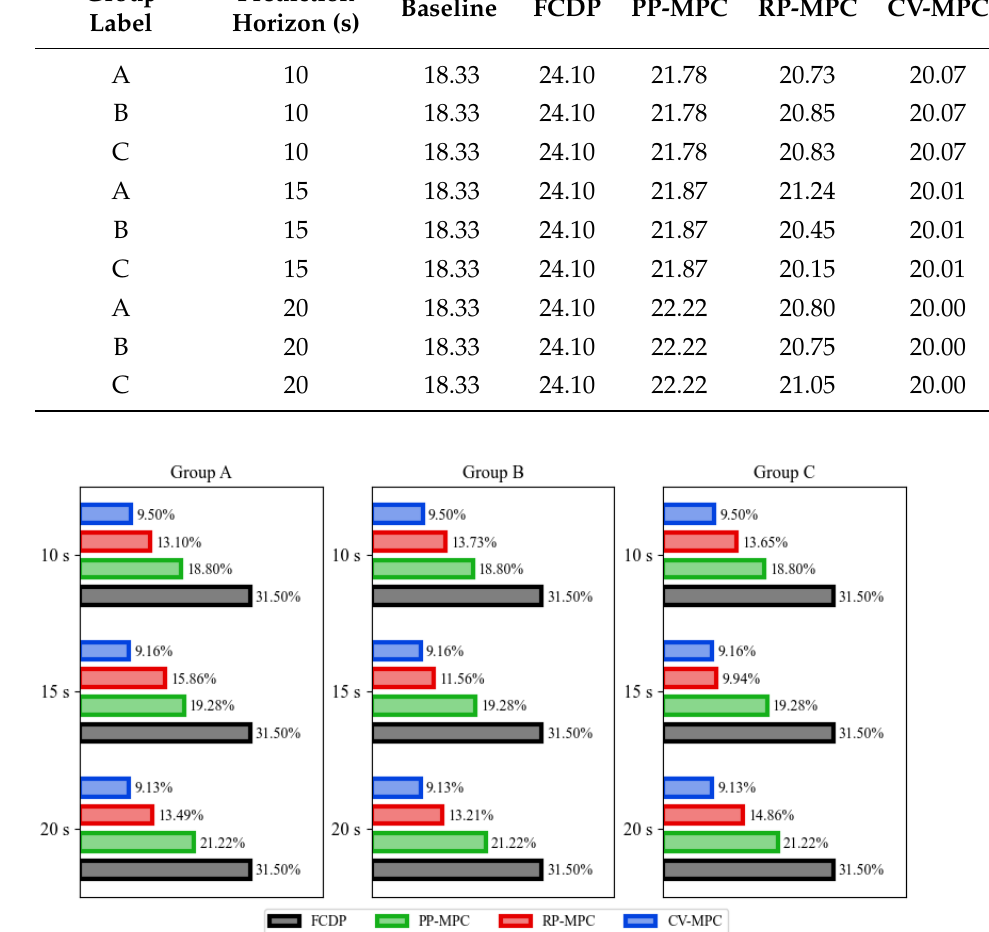
Figure 9. Percentage FE improvements for DP-derived methods for all data groups and time